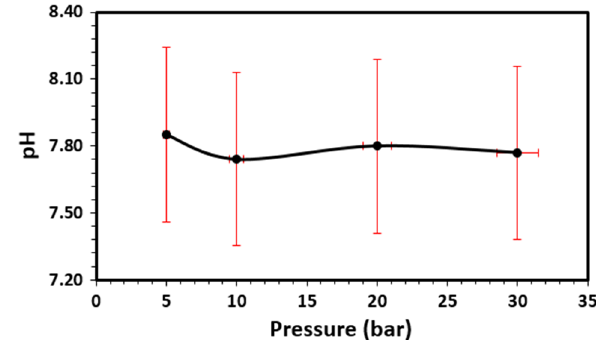
Fig. 9 Effect of different applied pressures on the treatment of the Red Sea water in membrane #3 (AFC40)